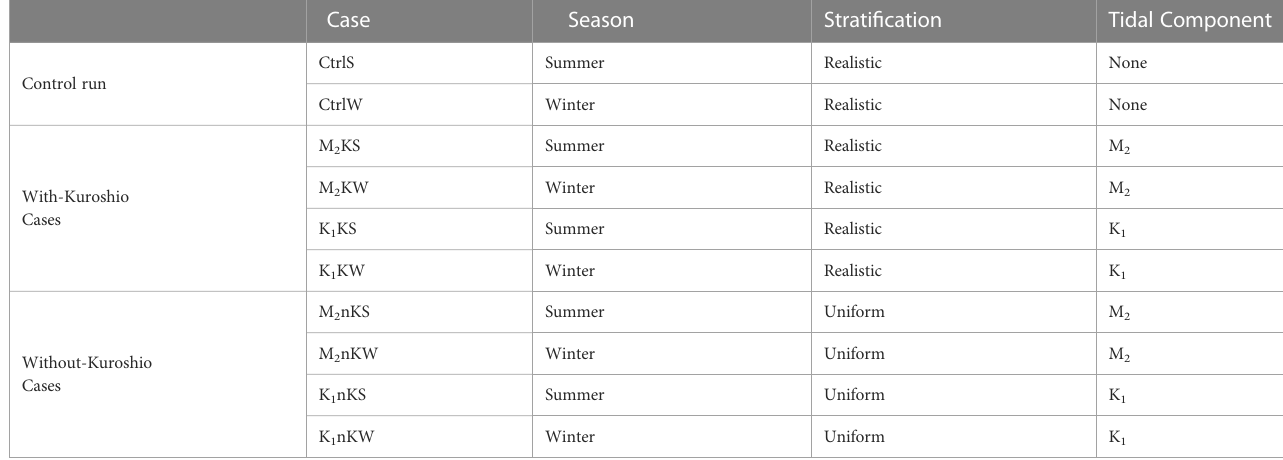
TABLE 1 Setup for each